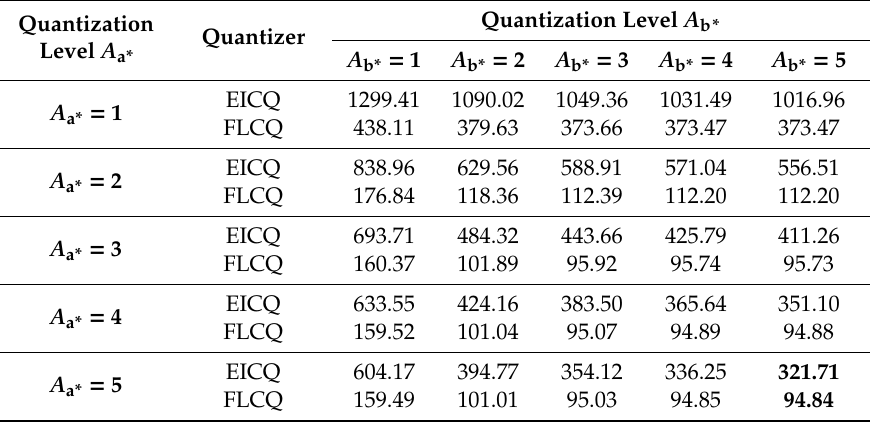
Table A5. The mean square error of the EICQ and FLCQ quantizers on KTH-2a. Quantization